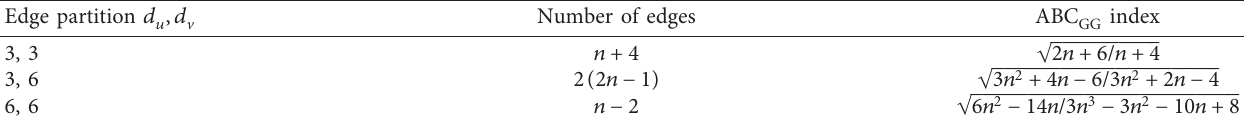
Table 9: Edge partition of chain silicate network of n order.